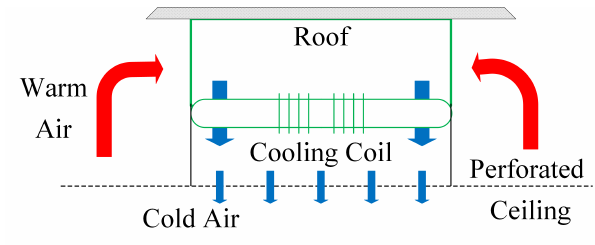
Figure 4. Schematic representation of PCB.